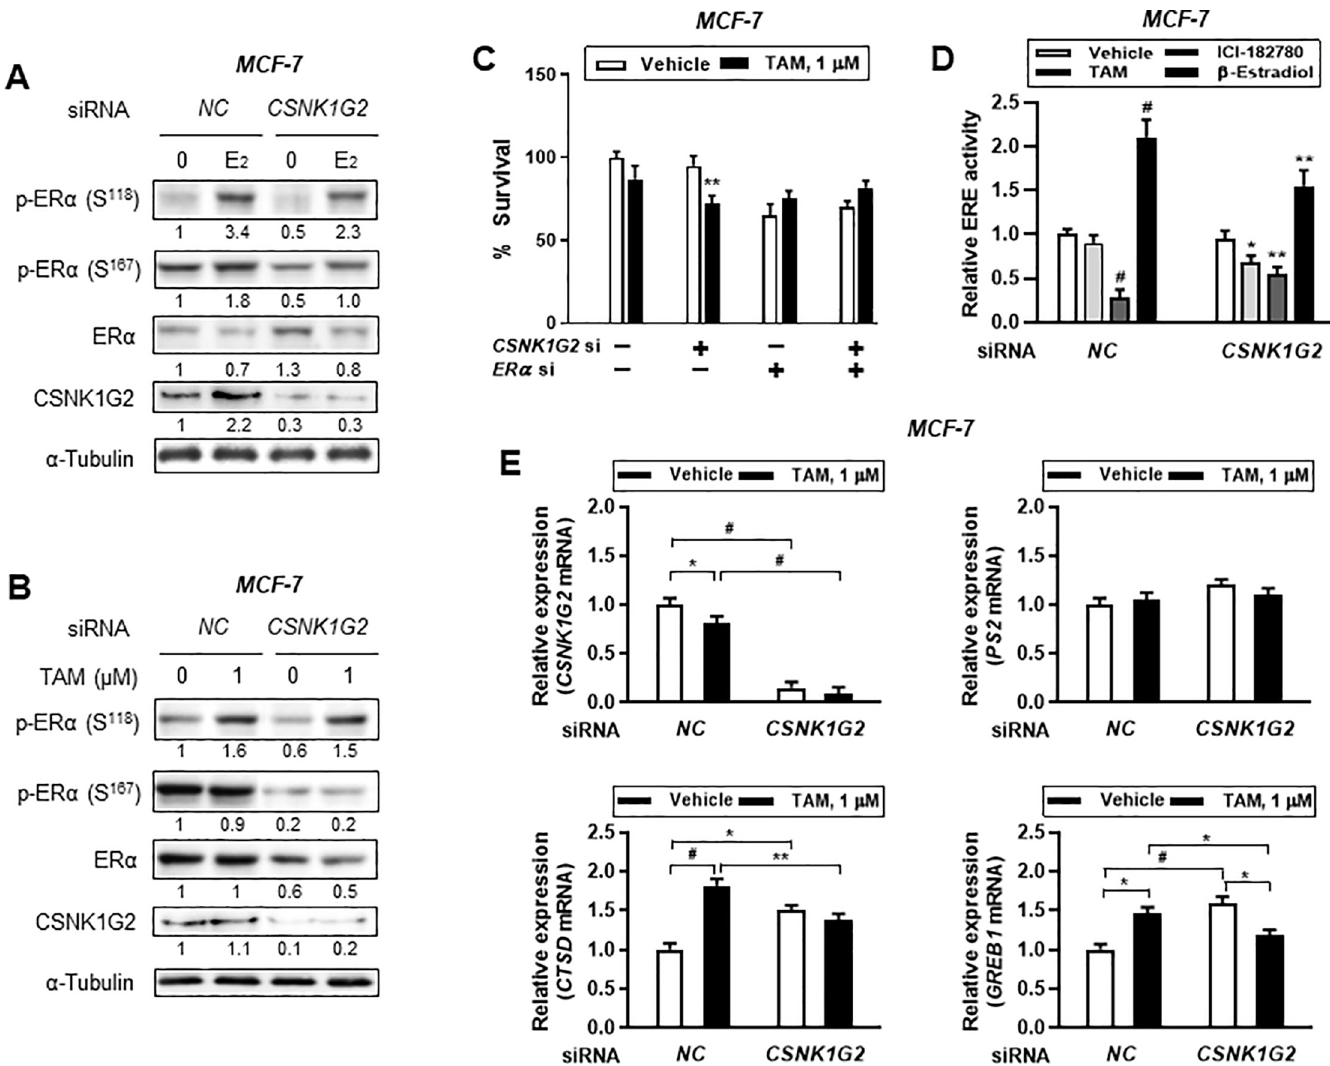
Fig 4. Effect of CSNK1G2 on TAM-induced ER activity in ER + breast cancer cells. Immunoblots for phosphor-ER (p-ER) in CSNK1G2 siRNA-transfected breast cancer cells after treatment with (A) 10 nM E 2 or (B) 1 μ M TAM for 24 h. Protein expression levels based on individual bands of phosphor form were compared to expression levels of α -tubulin and/or pan (total) protein. CSNK1G2 silencing efficiency was proved by western blotting for CSNK1G2. Each value under the blots indicates relative protein expression levels determined by densitometric analysis. (C) Cytotoxicity assay of CNSK1G2 -silenced ER + breast cancer cells. Cells transfected with different combinations of siRNA, such as NC siRNA alone, CSNK1G2 siRNA alone, ER α siRNA alone, or ER α plus CSNK1G2 siRNA, were treated with 1 μ M TAM for 24 h; cellular toxicity was then measured using the MTT assay. (D) ERE-luciferase reporter assay showing a significant change in TAM-treated MCF-7 cells. CSNK1G2 knockdown by siRNA transfection in MCF-7 cells slightly reduced 10 nM estradiol, 1 μ M ICI-182780, or 1 μ M TAM-mediated ER α transcriptional activity. (E) Quantitative analysis for mRNA expression in MCF-7 cells. Knock-down cells with NC or CSNK1G2 siRNA were treated with vehicle or 1 μ M of TAM for 24 h. Transcriptional patterns of diverse ER-responsive genes, PS2 , CTSD , and GREB1 , were analyzed by RT-qPCR in CSNK1G2 -silenced ER + breast cancer cells and were compared with those in NC siRNA-transfected control. All values were normalized to those in the NC siRNA-transfected vehicle group. GAPDH was used as a loading control and CSNK1G2 knockdown efficiency was also confirmed. Data are presented as mean (SD); n = 4; � P < 0.05, �� P < 0.01, # P < 0.001 vs . each represented